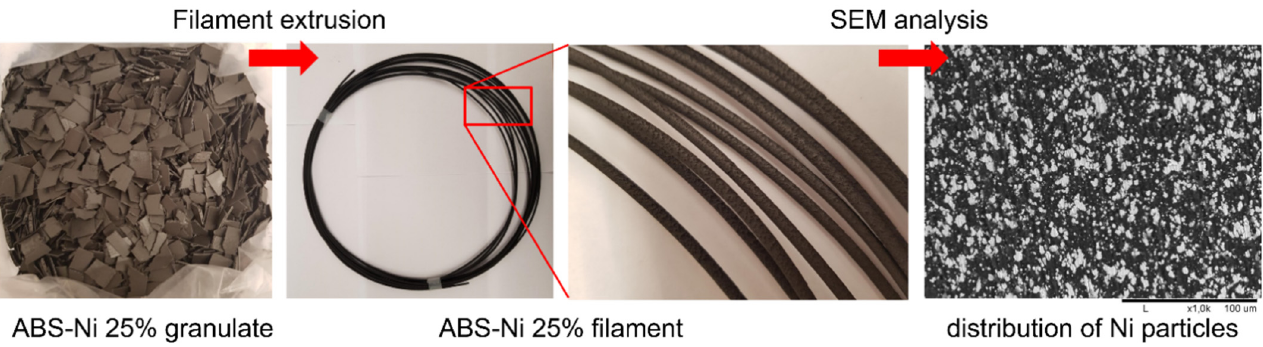
Figure 5. ABS-Ni 25% composite granulate and obtained filament. SEM image of the cross-section of the filament showing the distribution of nickel particles in the polymer matrix.